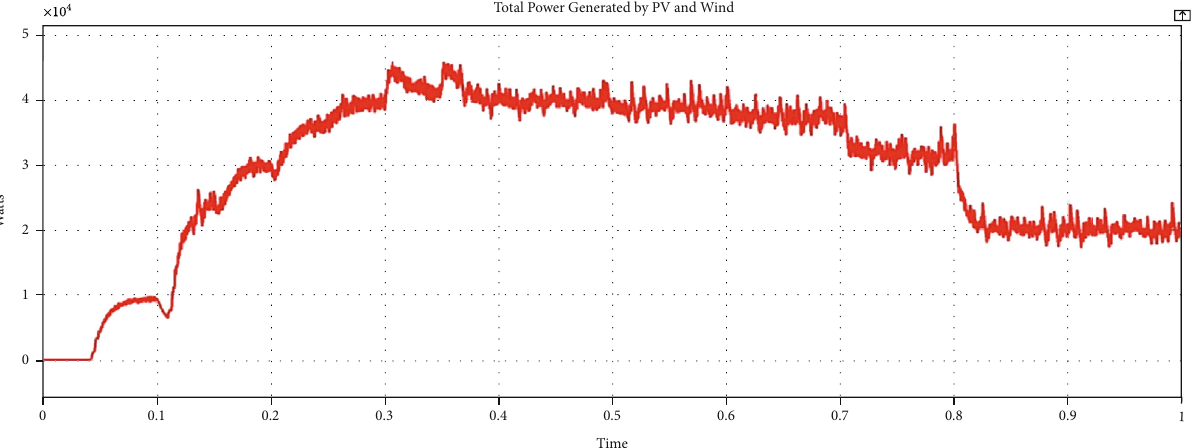
Figure 31: Total power generated by the hybrid PV/wind energy